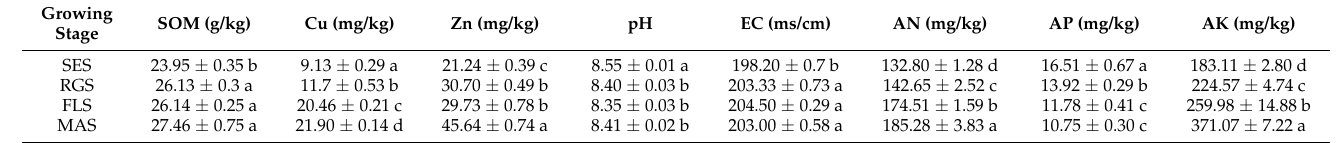
Table 2. Variations of soil physicochemical properties with different growth stages.